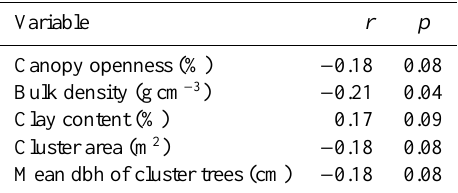
Table 2. Relationship between Wu 30d during soil desiccation period from 30 July to 1 September 2009 and selected stand structural vari- ables on the clusters. All 100 clusters were included in the analysis (Spearman’s rank